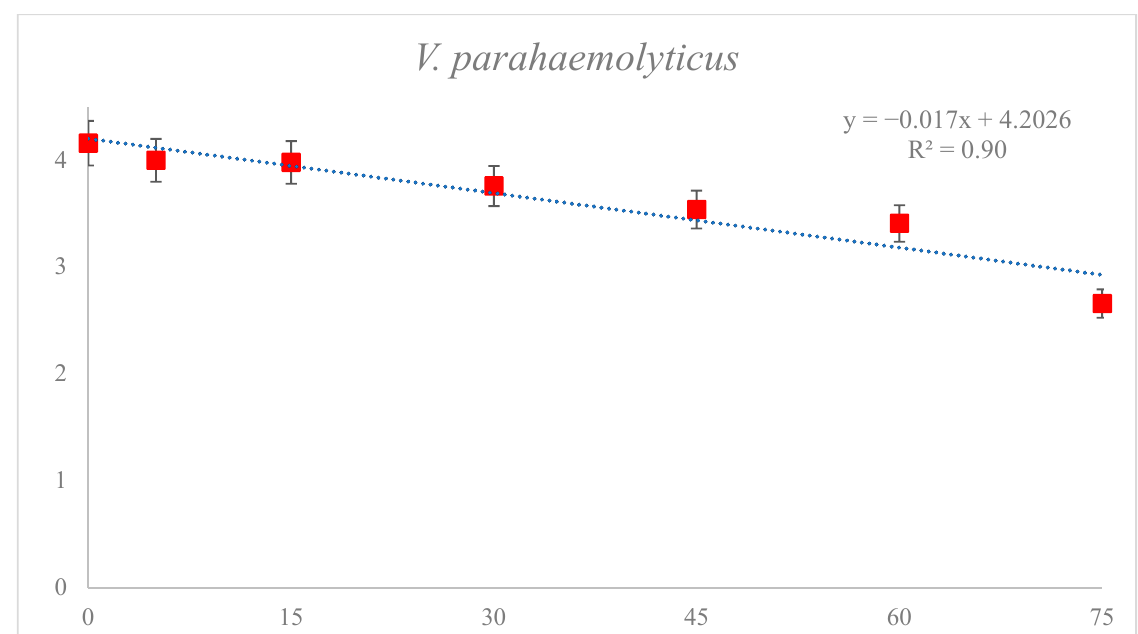
Figure 2. Fitted survival curves of V. parahaemolyticus infectivity from FE-DBD plasma-treated sea squirt using the first-order kinetic model. R 2 = correlation coefficient (a higher R 2 value indicates a better fit to the data). Data were represented as mean ± standard deviation of three independent replicates.